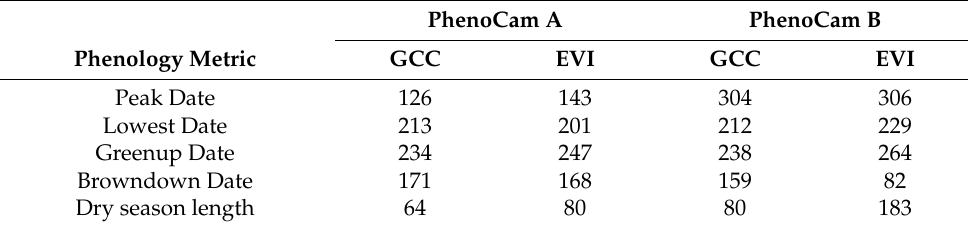
Table 4. Summary statistics of phenology metrics extracted by Landsat EVI time series and PhenoCam GCC time series in two PhenoCam sites.